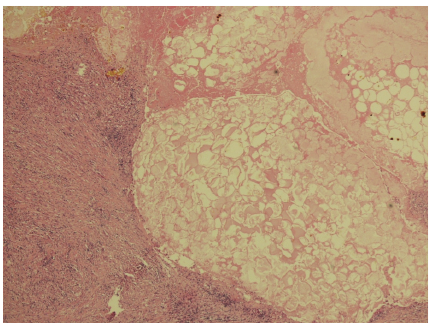
Figure5:Histologyshowingpericolonicscarringandinflammatory changes around foci of pancreatic fat